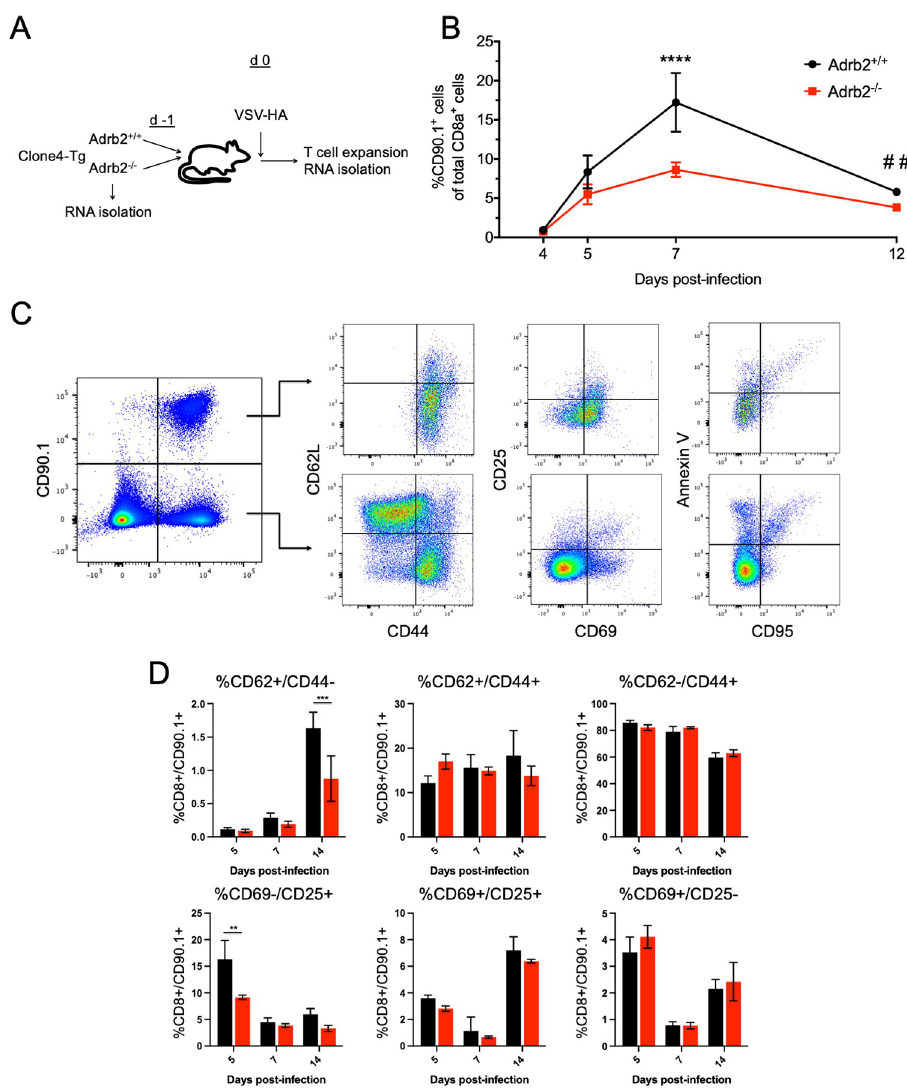
Fig 1. Differential expansion of Adrb2-/- cells in response to virus infection. ( A ) WT (CD90.1/1) and Adrb2 -/- (CD90.1/2) C4-Tg T cells were purified from donor animals and co-transferred (1:1, 1000 cells each) to BALB/cJ (CD90.2/2) recipients (n = 3 recipient animals/time point). On d1, recipient animals were infected with 1 x 10 6 pfu VSV-HA. ( B ) Separate cohorts of recipient animals were sacrificed at the indicated days post-infection. Expansion of transferred cells in pooled spleen and lymph node was quantified by flow cytometry by measuring the percentage of WT and Adrb2 -/- cells within the total proportion of congenic CD90.1 + cells ( ���� p < 0.0001 and ## p < 0.01 by two- way ANOVA). This experiment was performed 4 separate times with similar results. ( C ) WT and Adrb2 -/- CD8+ T cells were separately transferred to CD90.1 Balb/c recipients (3 recipient animals/genotype/time point) and infected with VSV-HA as above. Splenocytes assessed for cell surface receptor expression by flow cytometry. Cells were stained with antibodies to CD8, CD90.1, CD25, CD44, CD62L, CD69, with the addition of Annexin V to identify apoptotic cells. Expression of these markers were compared between the endogenous CD90.1-/CD8+ cells (lower panels) and the CD90.1+/CD8+ transferred cells (upper panels. ( D ) Percentage of specific CD90.1+/CD8+ populations assessed in C was quantified and compared between WT and Adrb2 -/- cells at each time point after infection. Significant differences were determined by 2-way ANOVA (5 separate similar experiments were performed).